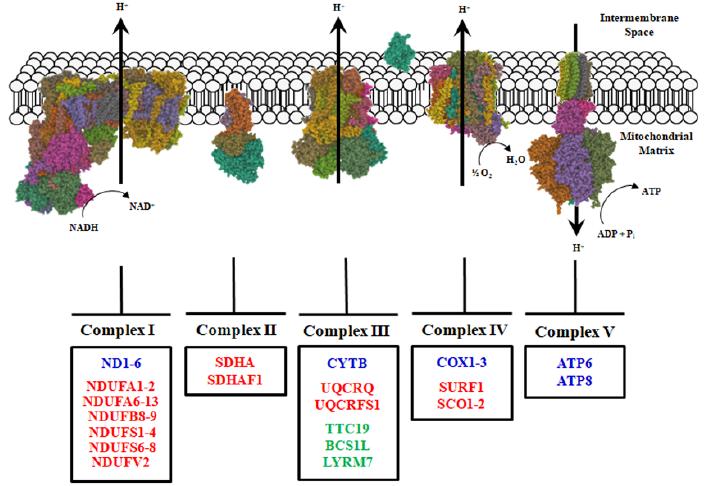
Figure 1. Mutations of the respiratory chain components in NMDs. The five complexes of the respiratory chain are schematized, and the various mutated subunits found in NMDs are reported. mtDNA-encoded subunits are highlighted in blue, while nDNA-encoded subunits are in red. Assembly factors that are not part of the mature complex are indicated in green. The structures of Complexes I–V were obtained from the Protein Data Bank (PDB) (http://www.rcsb.org/, accessed on 13 September 2021) with the accession codes PBD ID: 5LNK (Complex I), 1NEN (Complex II), 6FO0 (Complex III), 5Z62 (Complex IV), and 2XND (Complex V). For details see the text.